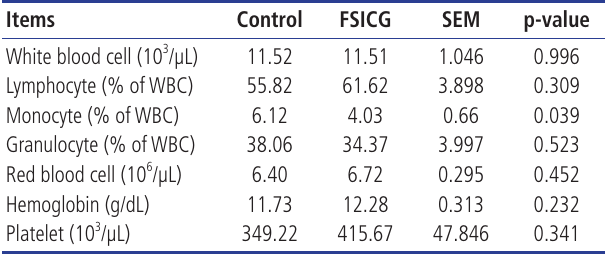
FSICG, fermented spent coffee ground; SEM, standard error of the means; WBC, white blood